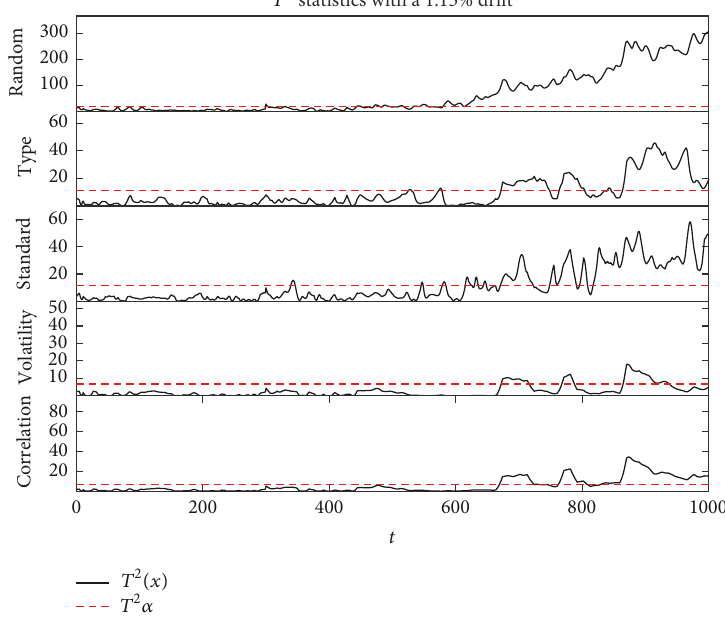
Figure 13: 𝑇 2 statistics with a larger drift in 5 PCA models. Q statistics with a 1.15% drift